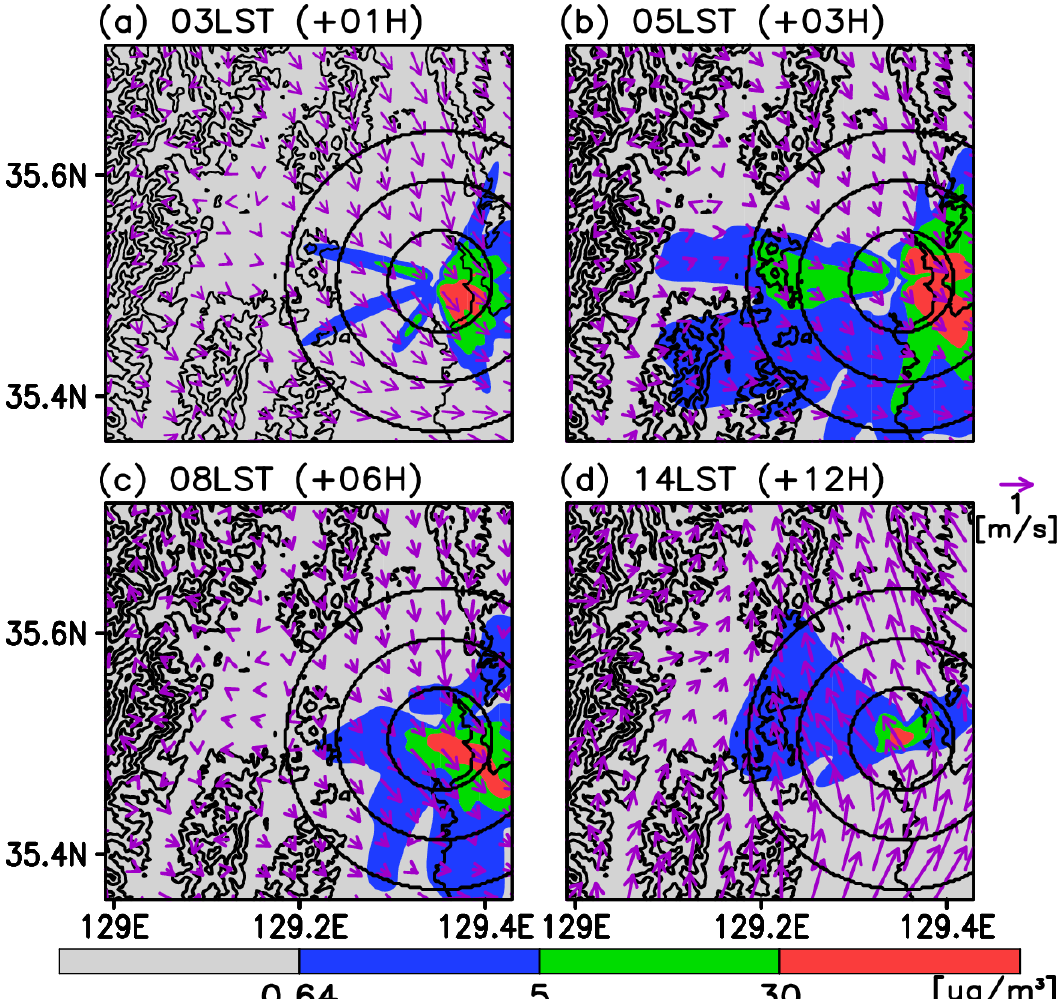
Figure 6. Time ‐ averaged benzene concentration (shaded, unit: μ g m − 3 ) and surface wind (arrow, unit: m s − 1) of the nighttime emission ‐ started cases. Each panel shows the patterns at ( a ) 03:00 LST, ( b ) 05:00 LST, ( c ) 08:00 LST, and ( d ) 14:00 LST, which are 1, 3, 6, and 12 h after the emission starts, respectively. Also shown is the topography (contour in black). Three circles indicate the distance from the emission source to 5, 10, and 15 km.